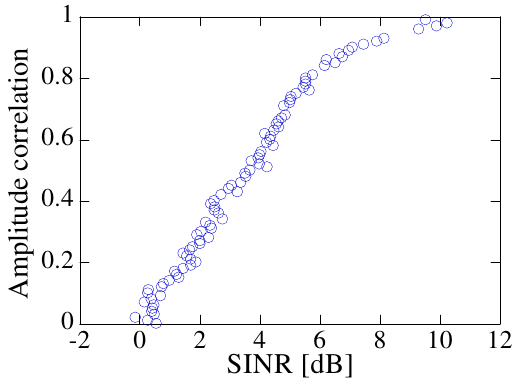
Figure 3. Relationship between amplitude correlation and signal-to-interference noise ratio (SINR).